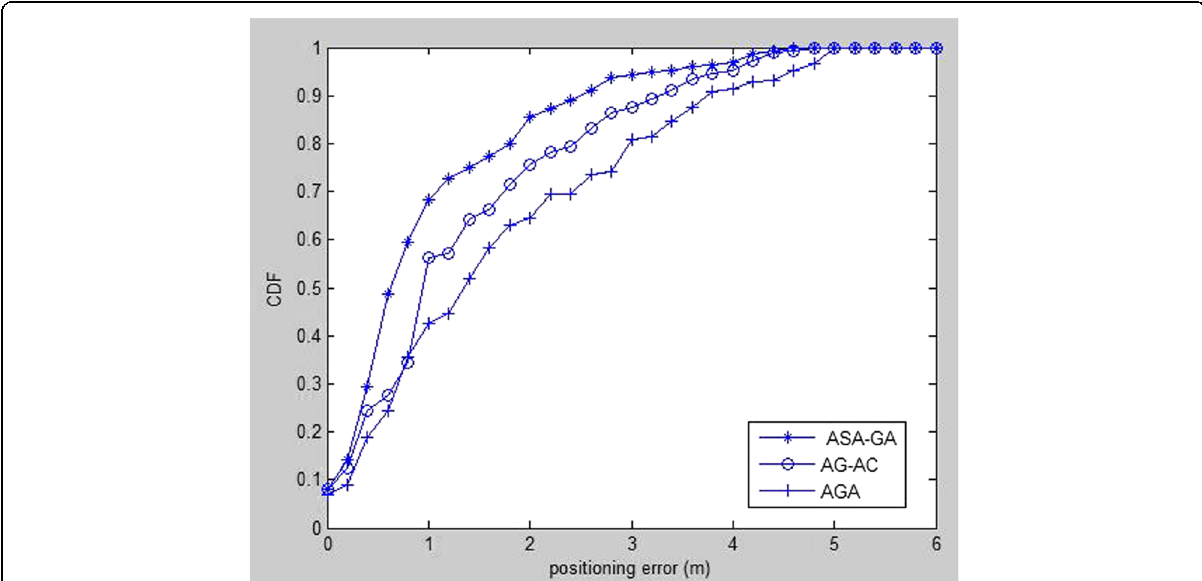
Fig. 5 Three optimization algorithms positioning error accumulation distribution diagram. The curve with circles represents after AG-AC algorithm optimization, the curve with stars represents after ASA-GA algorithm optimization, and the curve with crosses represents after AGA algorithm